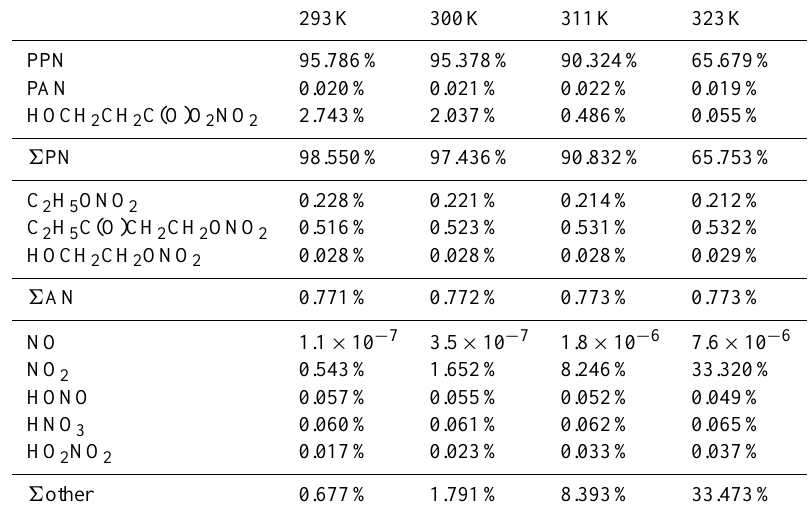
Table 2. Product yields of PPN and side products as a function of temperature predicted by box modeling.